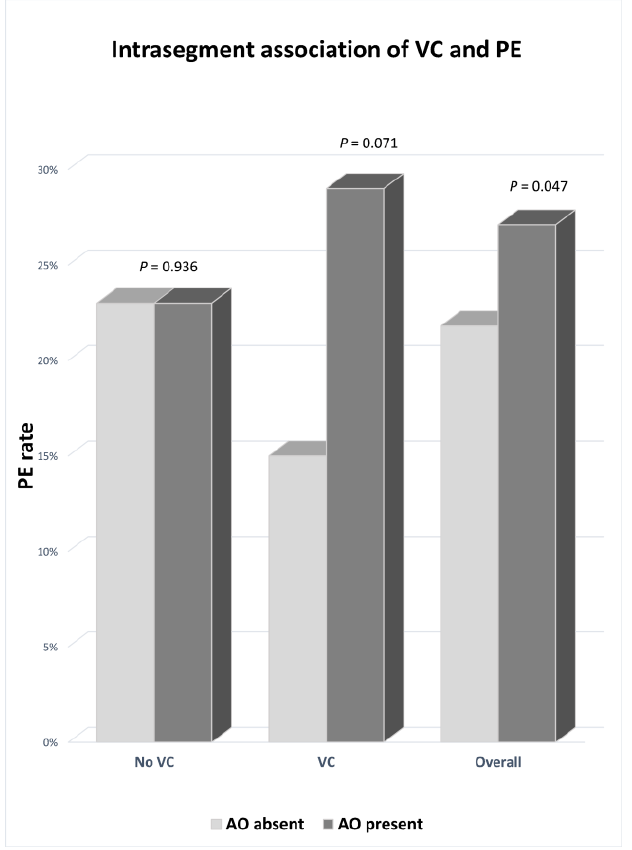
Figure 5. Intrasegment association of VC and PE. Graph shows the association between the rate of segmental or subsegmental PE found in segments with or without VC, respectively, stratified by the presence of AO. In the absence of VC, AO does not influence the PE rate. Conversely, when VC is present, AO markedly affects the probability of PE (n = 254 emboli). Statistical significance is reached only in the whole population due to higher statistical power (n = 329 emboli).